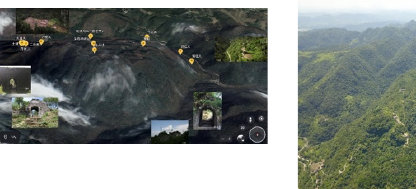
Figure 7 . Aerial photograph of Longyan Mountain